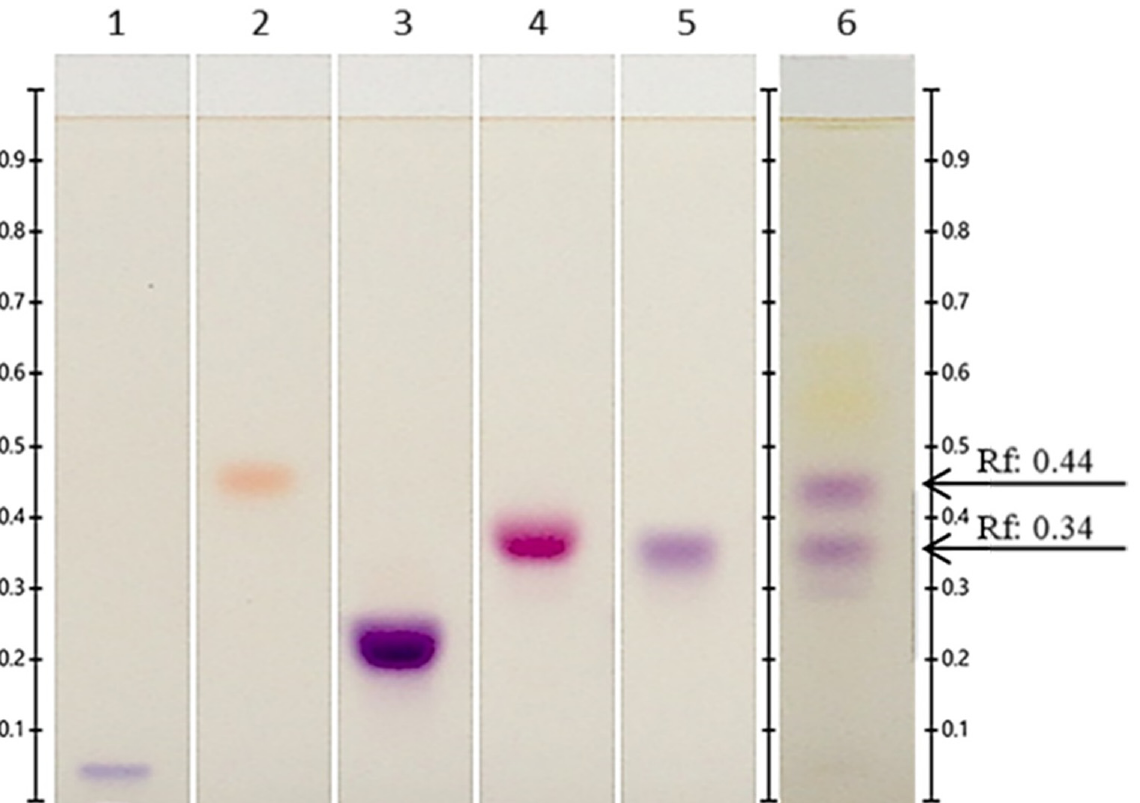
Figure 3. Identification of anthocyanins by HPTLC in extracts of Vaccinium stenophyllum Steud. fruits, taken under white light, after derivatization with NP reagent. Track 1: delphinidin-3-5-diglucoside; Track 2: pelargonidin-3-glucoside; Track 3: cyanidin-3-rutinoside; Track 4: malvidin-3-glucoside; Track 5: cyanidin-3-glucoside. Track 6: Vaccinium stenophyllum Steud. fruit extract (stage 4) was applied in triplicate, volume = 2 µL (20 mg DW/mL). Band from extract not identified with standard (Rf: 0.44). Band from extract identified as cyanidin-3-glucoside (Rf: 0.34).